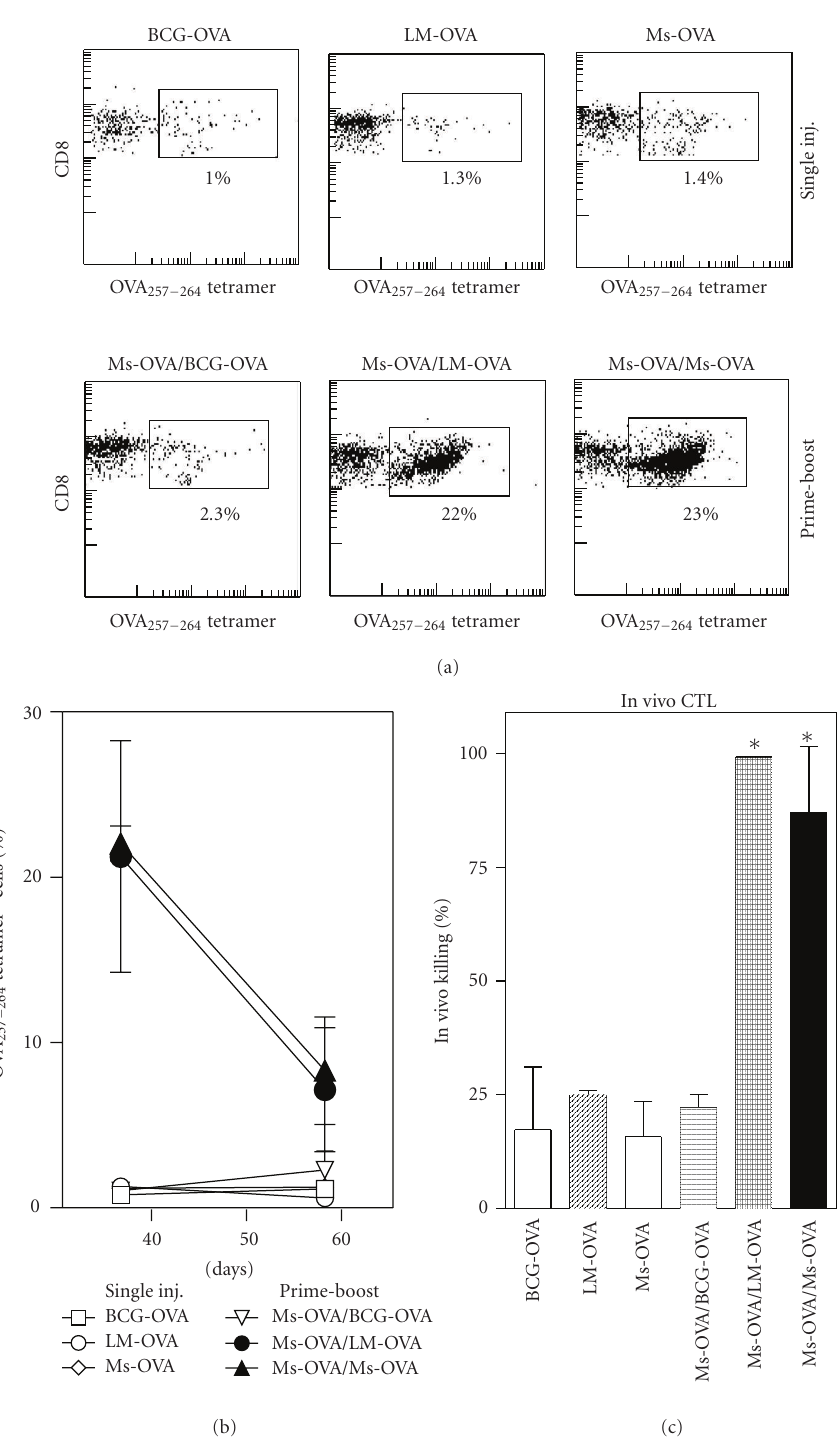
Figure 1: CD8 + T cell response after heterologous prime-boost with archaeosomes and live vectors. Mice were vaccinated (subcutaneously) with Ms-OVA (20 μ g OVA entrapped in Ms archaeosomes, 94.1nm average size, 38 μ g/mg loading), or 10 4 CFU of live LM-OVA or BCG- OVA. Prime-boost regimens involved the same Ms-OVA vaccine given on days 0 and 30, or heterologous boost on day 30 with the BCG-OVA or LM-OVA vector. The CD8 + T cell response was evaluated based on the percentage of OVA 257–264 tetramer positive cells in the blood (a, b) and in vivo CTL response (c). (a) Representative scatter plots showing tetramer positive cells on day 7 after a single injection (top panel) or after prime-boost on day 37 (bottom panel). The square gate indicates percentage of tetramer positive cells in the blood of immunized mice. (b, c), Mean ± SD of 5 mice per group. ∗ Response was statistically significant from single dose group by student’s t -test ( P < .